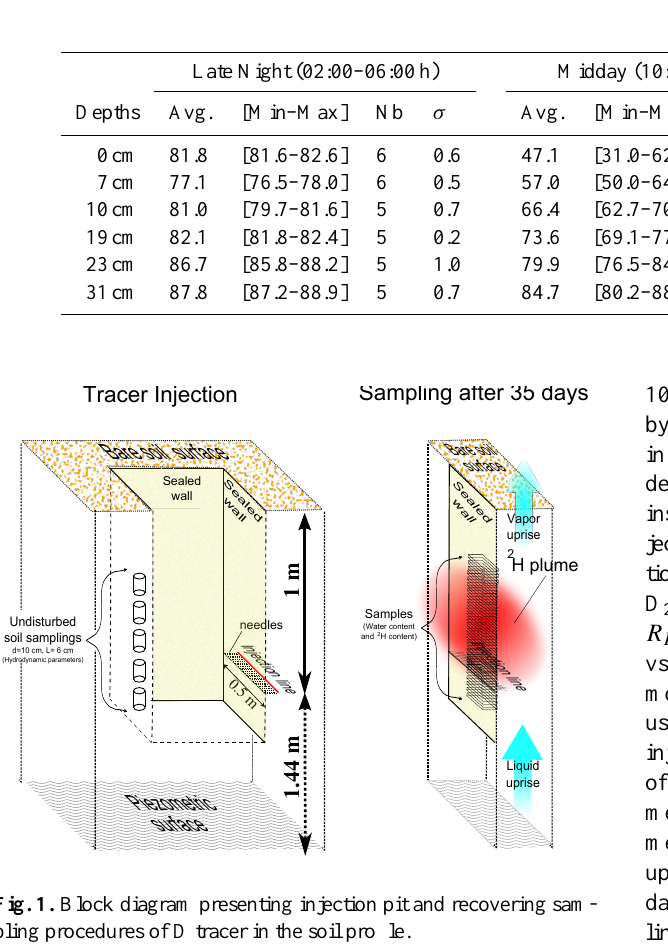
Table 1. Relative humidity (%) measured on 19, 20, 21 and 22 June 2001 in the soil top layer aside the sampling pit. For a 0cm depth measurement, the capacitance probe was at the soil surface. For 7cm, 10cm, 20cm, 23cm and 31cm depths, the probe was inserted in a 40-cm long PVC tube driven horizontally in the soil from the wall of a pit. Measurements were taken after 5min contact with soil moisture. (Avg.=average, [Min-Max]=interval of extreme values, Nb=Number of measurements, σ =Standard deviation).